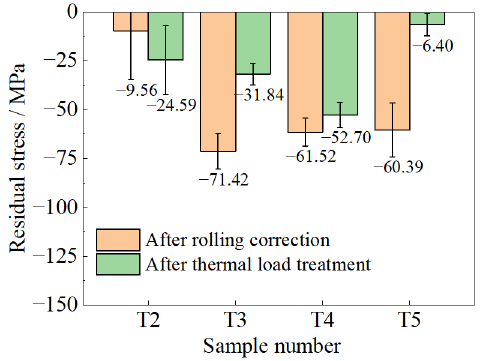
Figure 5. Residual stress detection results of the milling area after rolling correction and thermal load treatment.